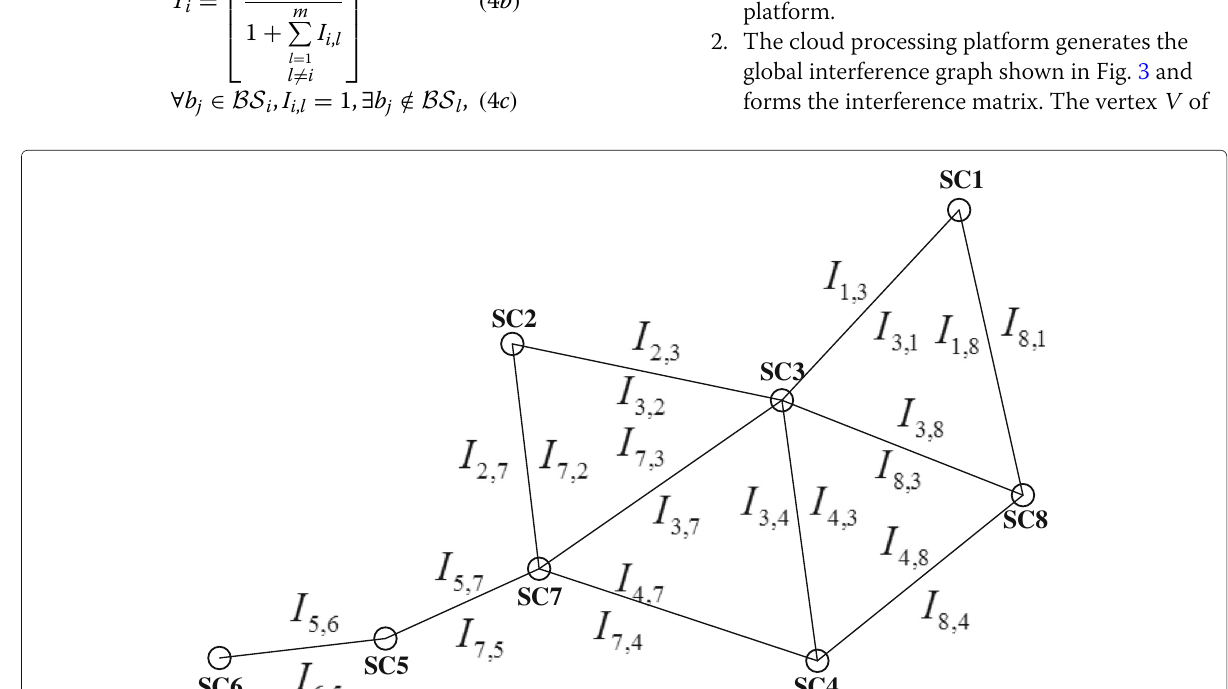
Fig. 3 The global interference